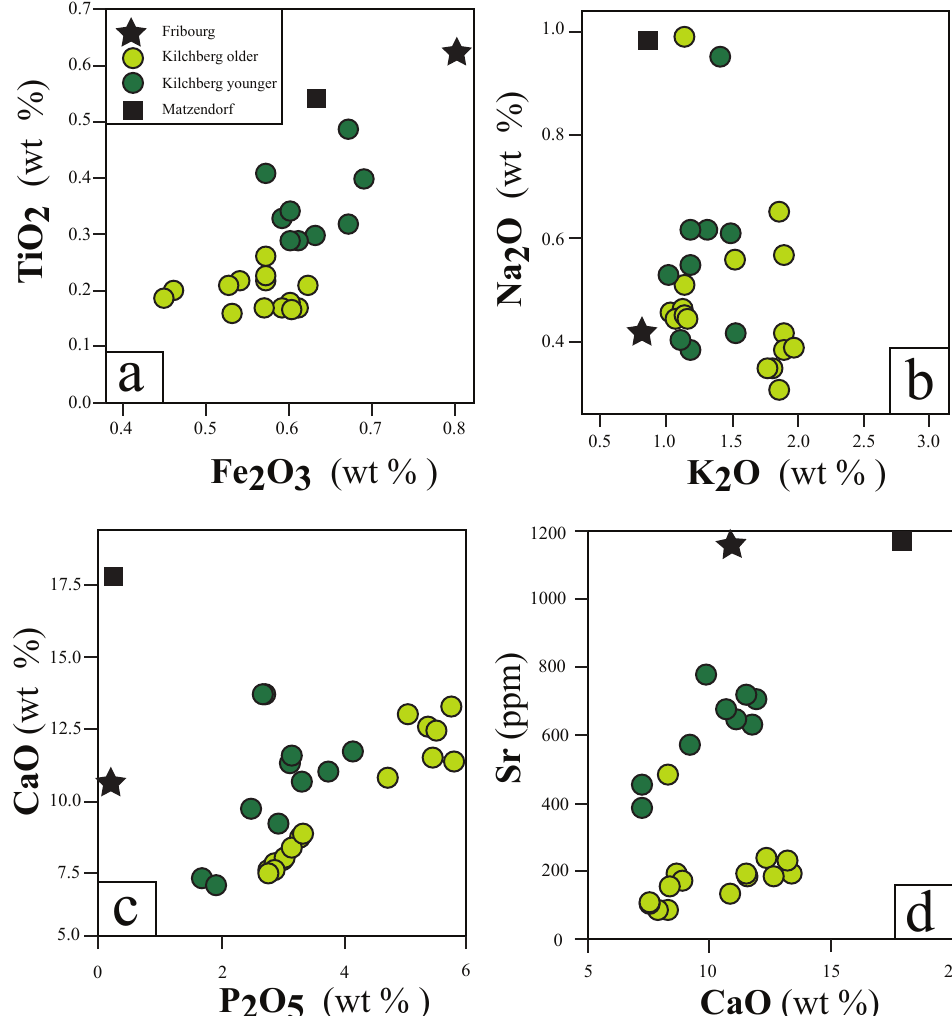
Figure 14. Body (bulk) compositions for the Eastern Swiss CaO-rich samples displayed on four selected binary diagrams. See discussion in the